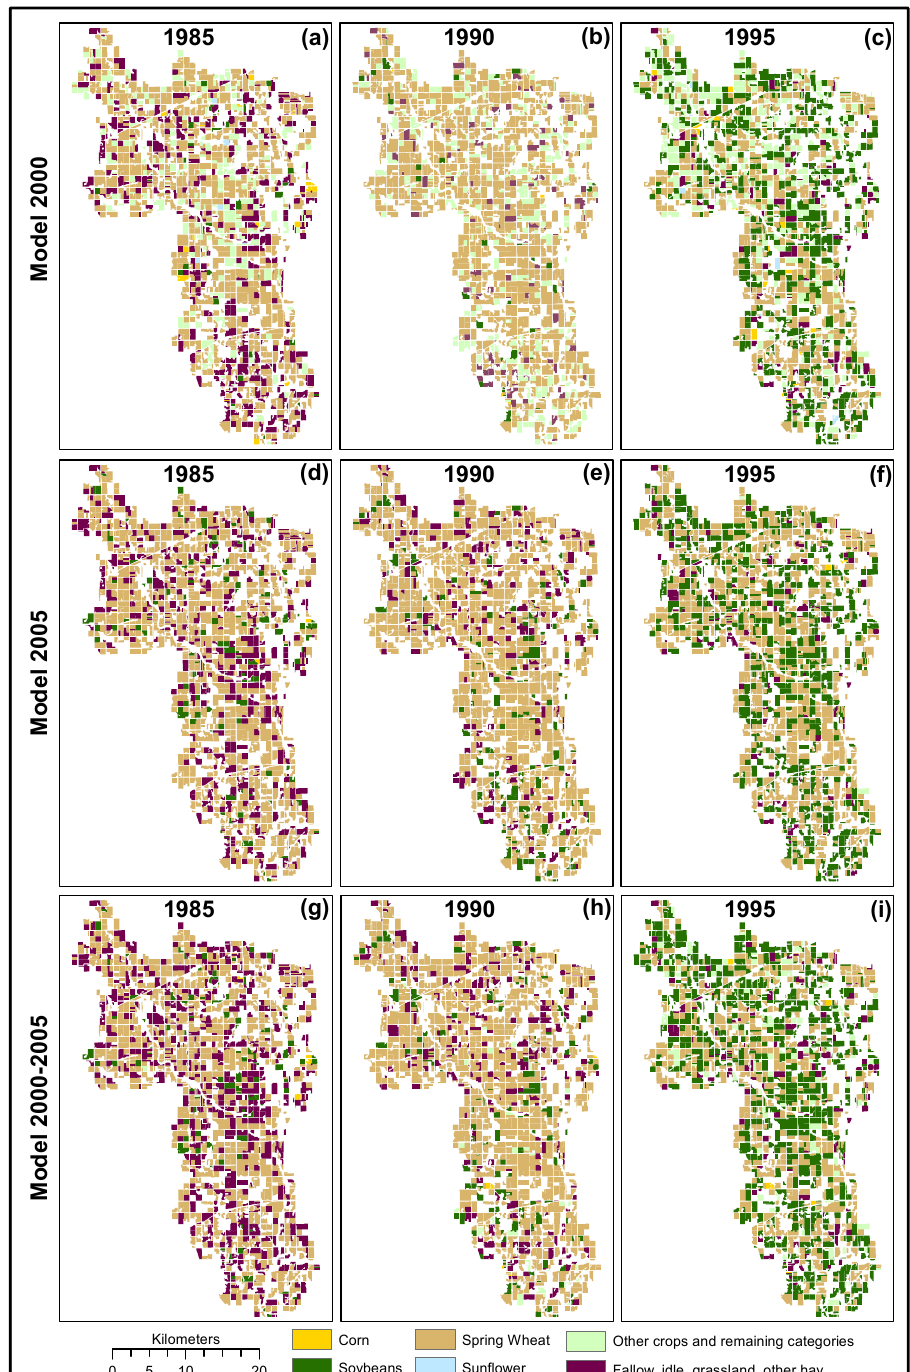
Figure 6. Crop-type predictions at the field-scale generated using machine learning models developed using Landsat NDVI time series and crop data layers of 2000 ( a – c ), 2005 ( d – f ), and combined 2000–2005 ( g – i